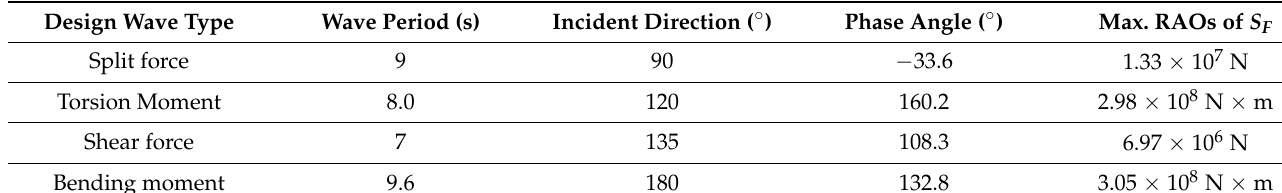
Table 3. Wave parameters selected by design wave method.